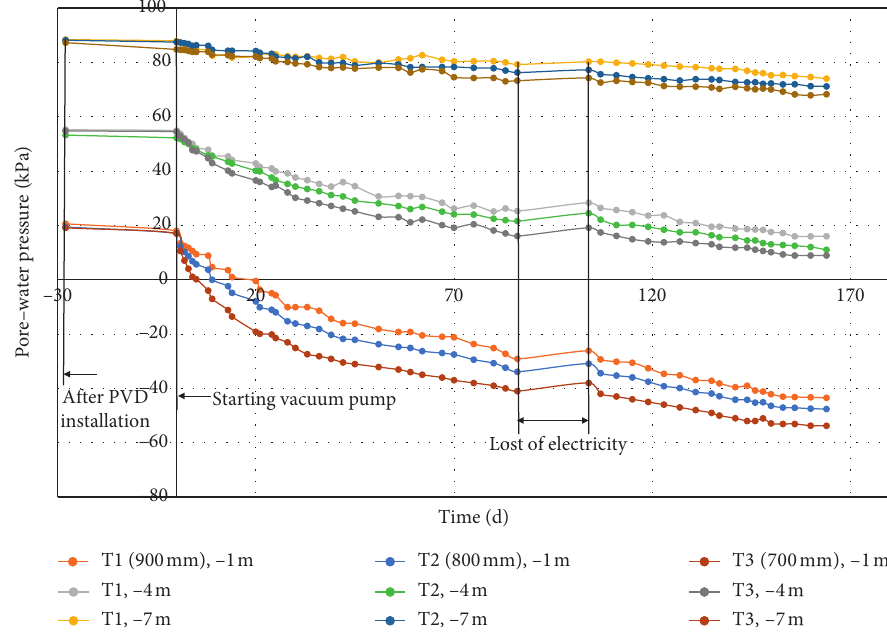
Figure 8: Variations of pore water pressure at different depths.